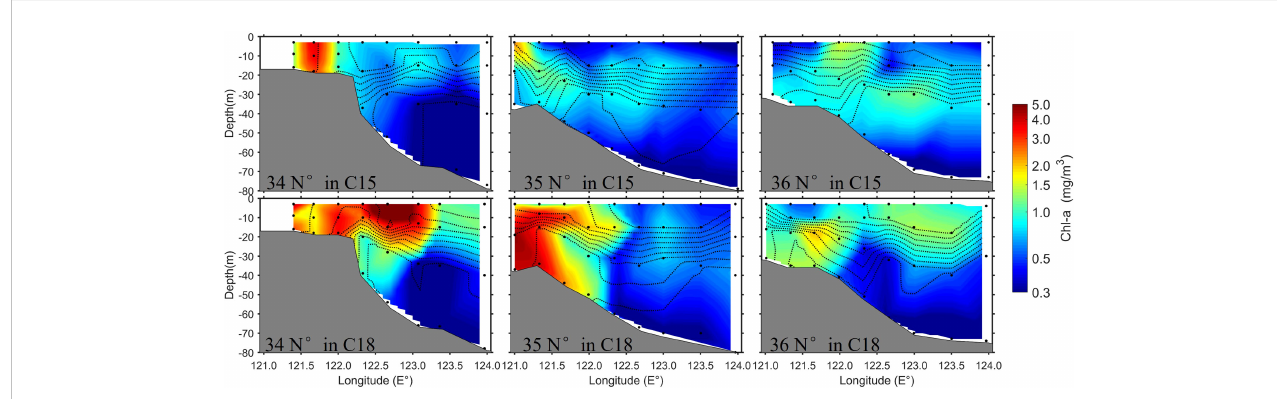
TABLE 2 Nutrient fl uxes to the upper layer by different dynamic processes in the Yellow Sea during summer.